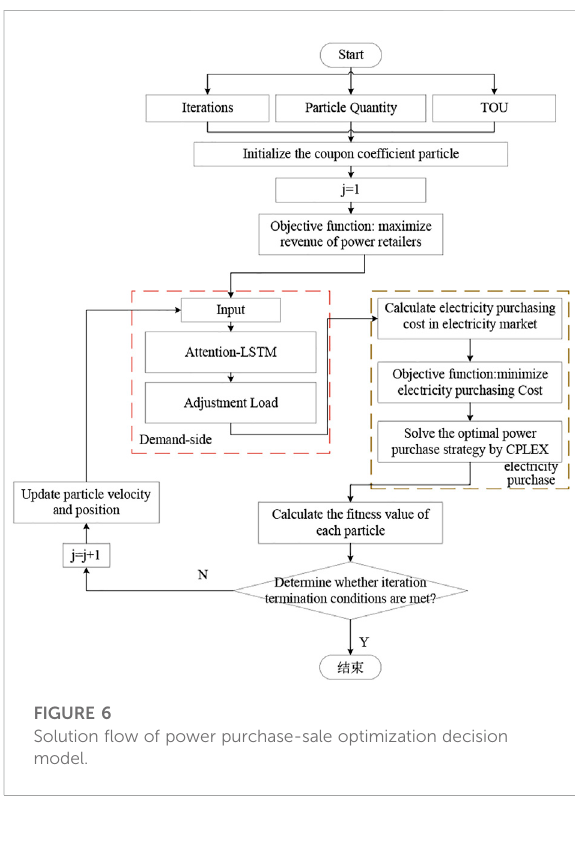
FIGURE 6 Solution fl ow of power purchase-sale optimization decision